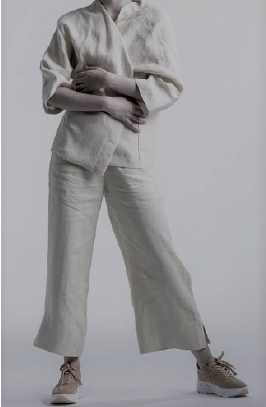
Figure 8. Hemp clothing functionalized by CBD extract.